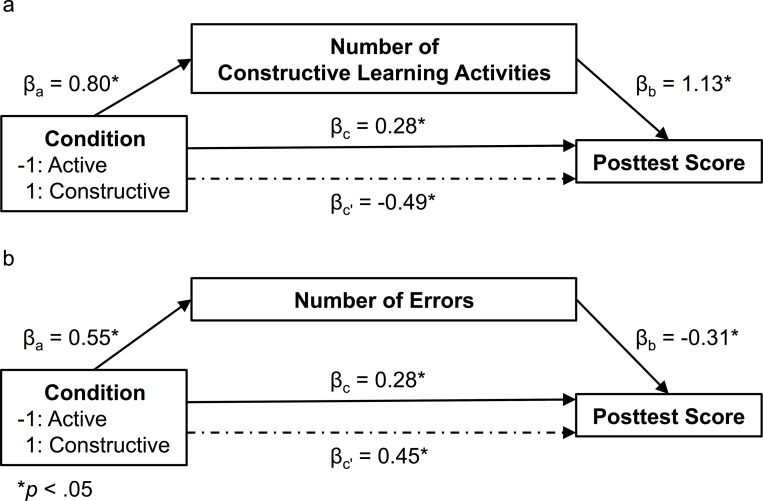
Results of the mediation analyses in Experiment 1.